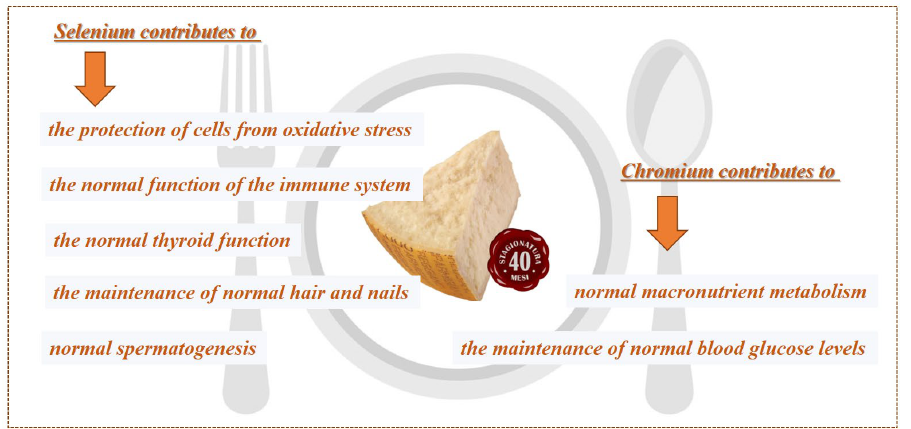
Figure 2. Health claim for selenium and chromium, according to the Regulation (EU) 432/2012.